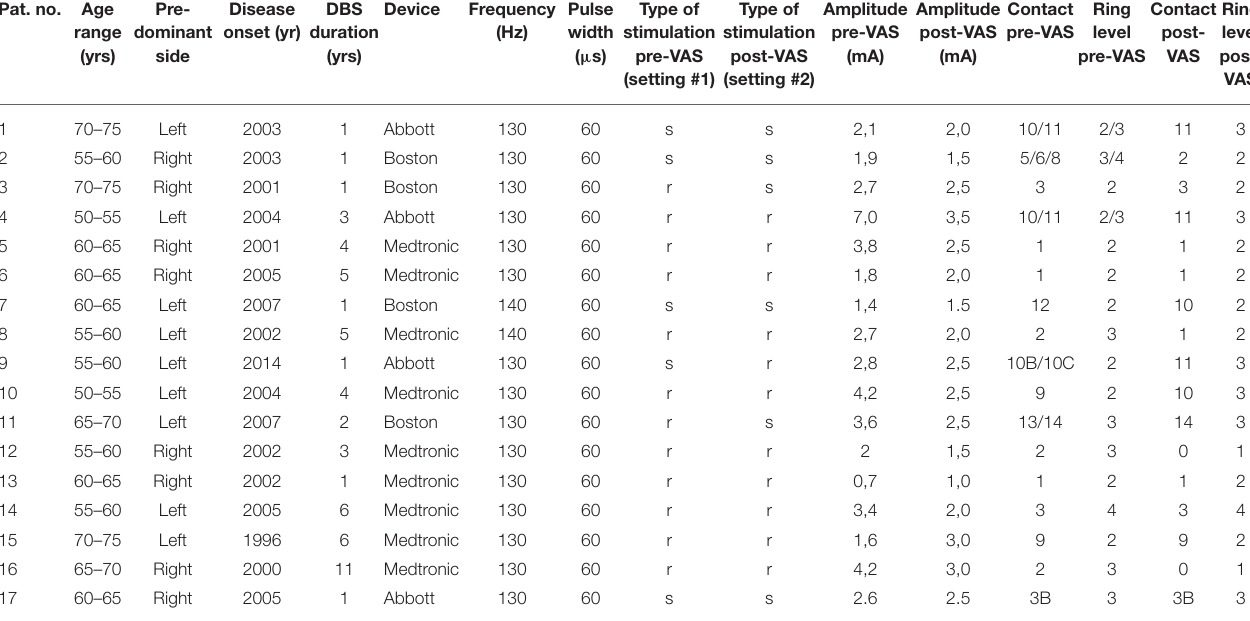
TABLE 1 | Table summarizing the demographical and device-associated characteristics of the study subjects prior to and subsequent to VAS-based DBS adjustment. Pat. no. Age